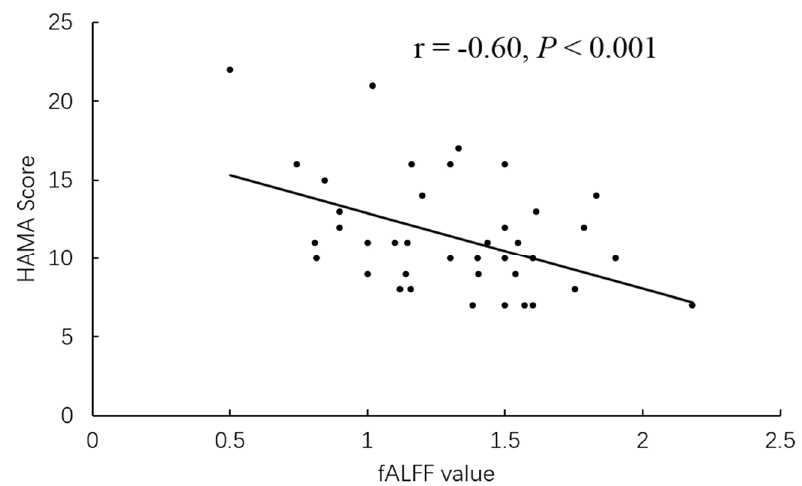
Figure 4. In PD-A patients, the fALFF value of the left caudate showed a negative correlation with HAMA scores. Table 2. Brain regions with significant differences in fALFF among the three groups.